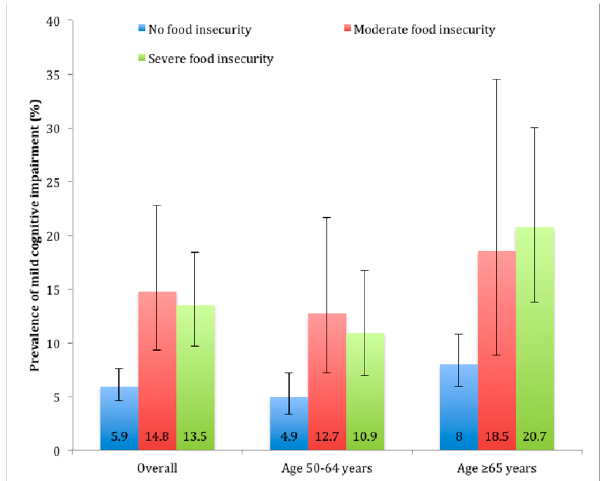
Figure 1. Prevalence of mild cognitive impairment by food insecurity status. Estimates are based on weighted sample. Bars denote 95% confidence interval.